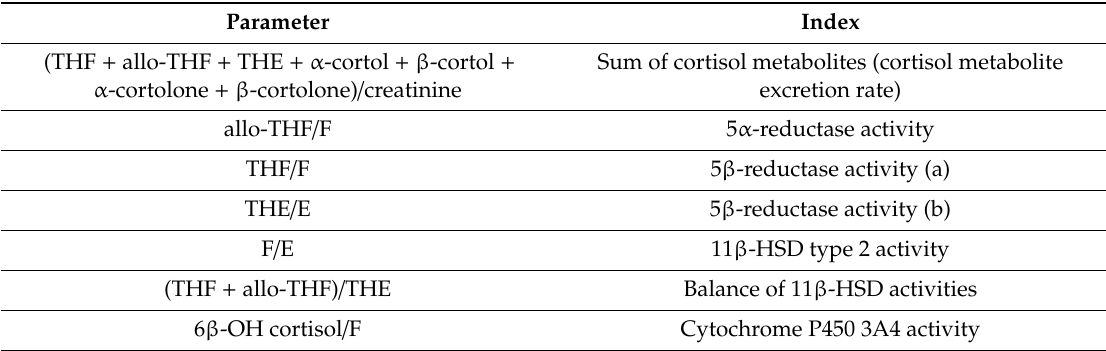
Table 1. Cortisol parameters reflecting cortisol production and cortisol metabolism pathways. Parameter Index Sum of cortisol metabolites (cortisol